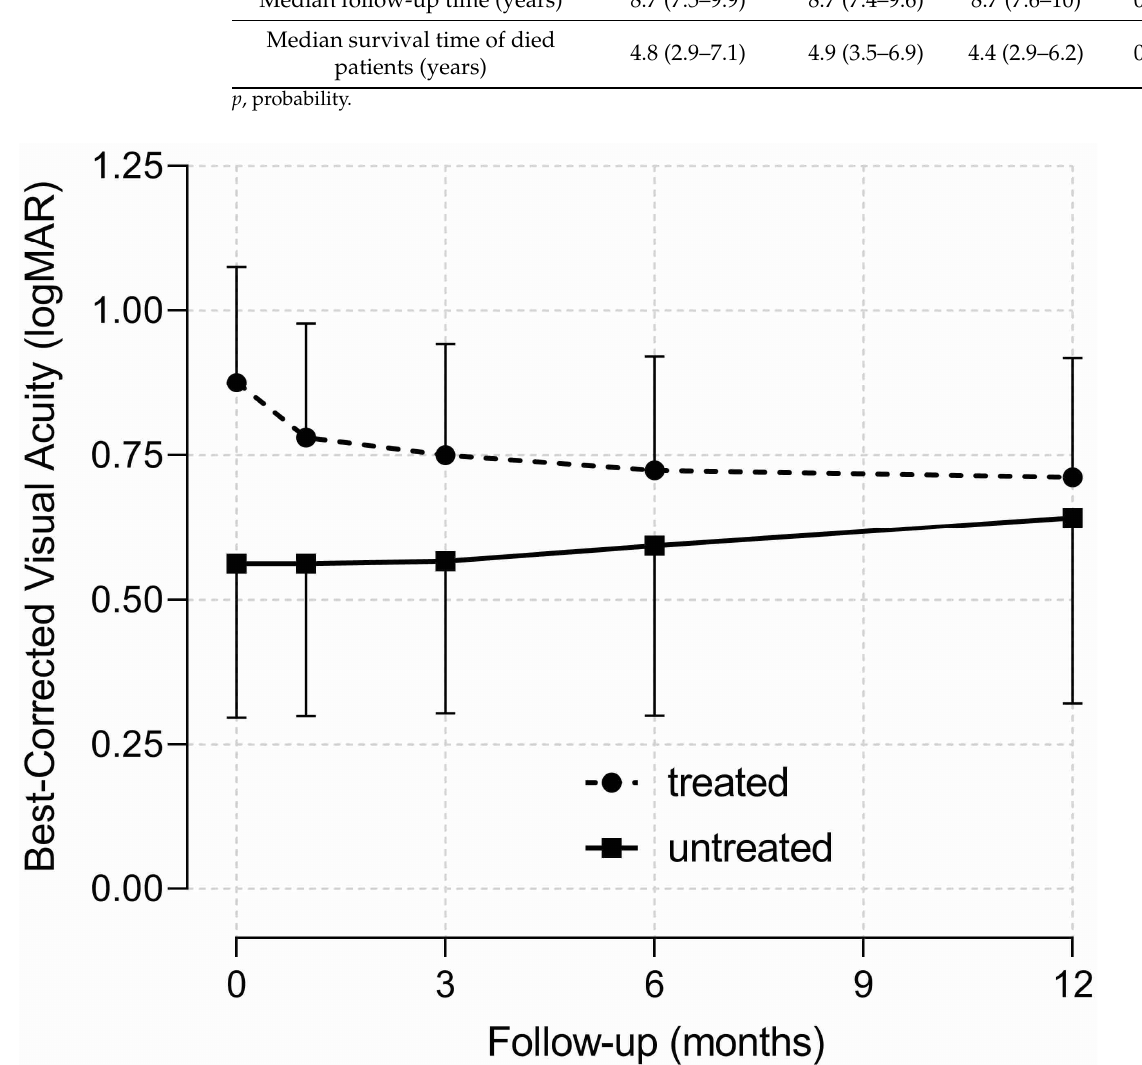
Figure 1. Best-corrected visual acuity of hypertensive patients with retinal vein occlusion at baseline (time 0) and during one-year follow-up after receiving (dashed line) or not (solid line) antithrombotic treatment and respective 95% confidence intervals (vertical capped lines). Table 2. Ophthalmological outcomes, composite endpoint components, and median survival time at the end of follow-up of patients treated and untreated with antithrombotic agents.